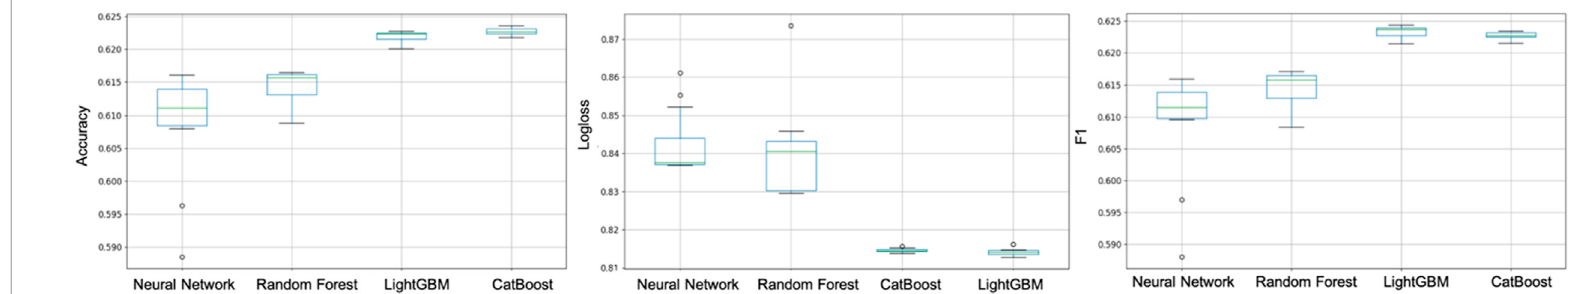
FIGURE 2 | Performance comparison for four machine learning models.